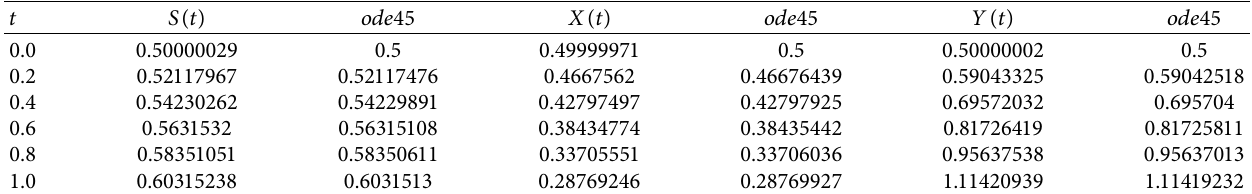
Table 33: Comparison between solutions obtained by the LeNN-WOA-NM algorithm and ode45 for the prey-predator model with � 0 . c 1